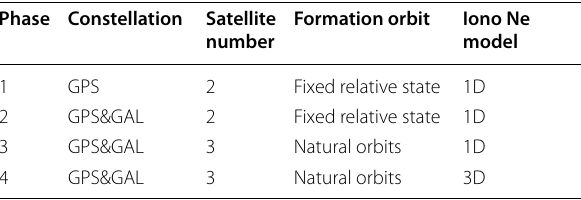
Table 1 KPI table of four VTFFTB development phases (Iono Ionosphere; Ne electron density) =